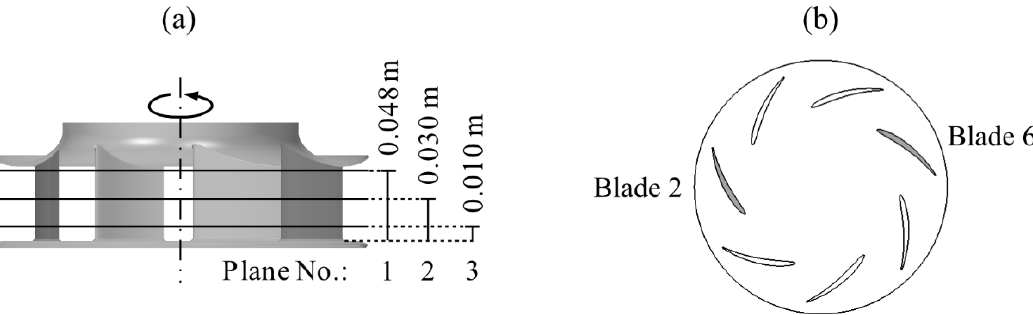
Figure 3. ( a ) The cut planes for monitoring contours of the flow quantities. ( b ) The blades (in gray) followed to observe periodic evolutions of the transient flow field.